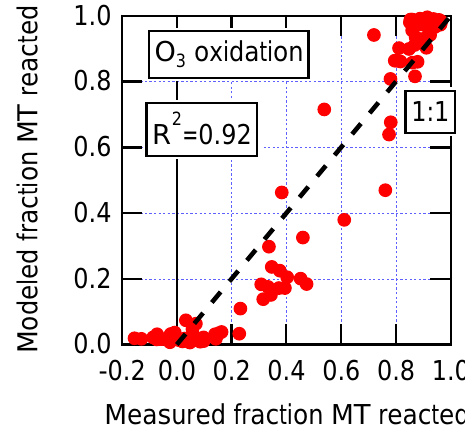
Figure 3. Modeled vs. measured fraction MT reacted by O 3 oxida- tion in the O 3